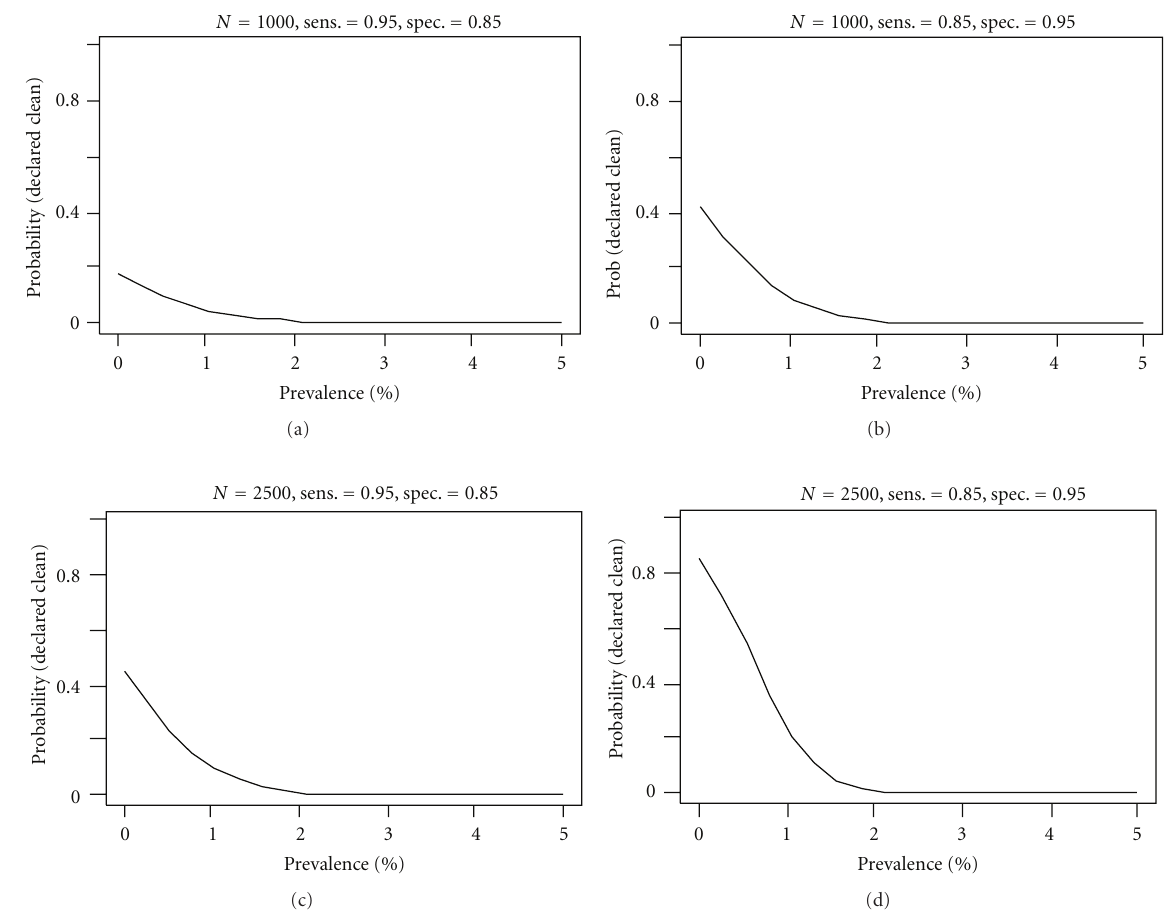
Figure 2: Di ff erent sensitivity and specificity scenarios. Each panel shows the probability of declaring a region is free of disease (clean) as a function of true prevalence. It is computed based on 99% confidence at prevalence target 2%. Higher probability at zero prevalence is more desirable.